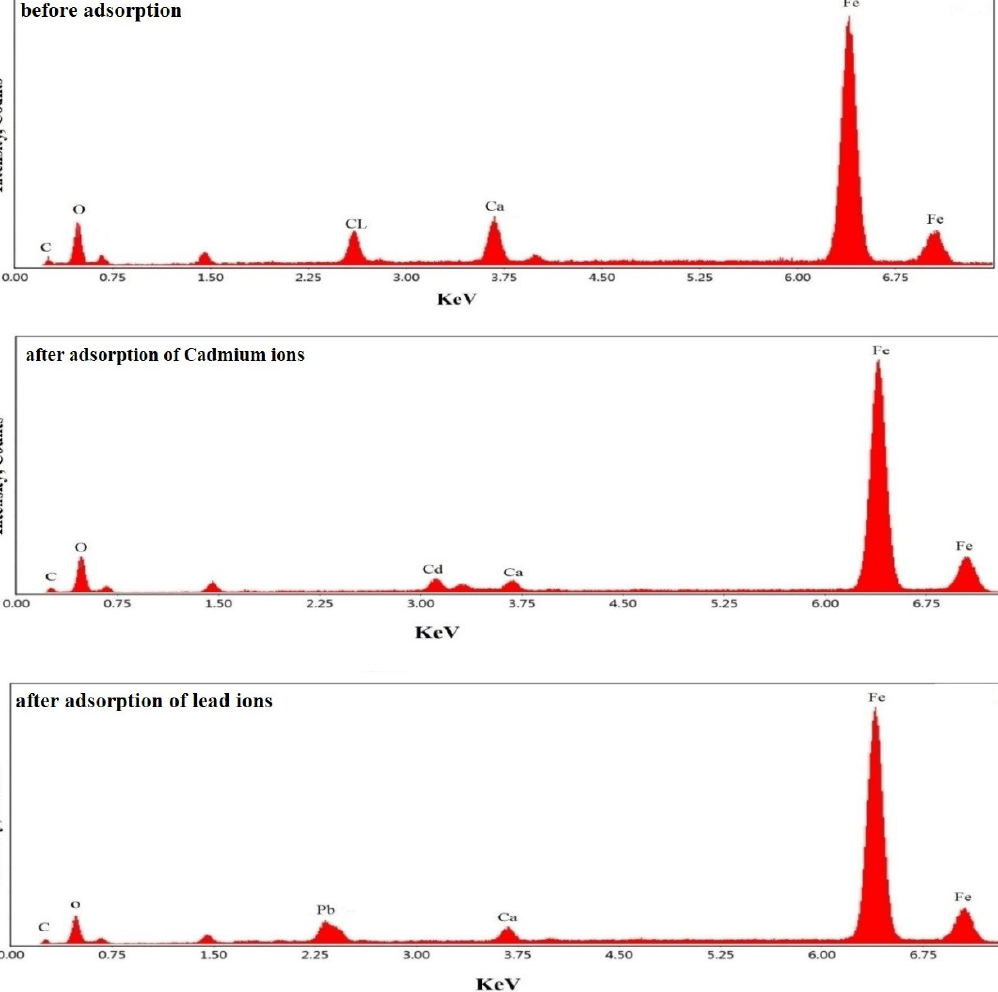
Fig. 3 b. The EDS spectra of adsorbent before adsorption, after adsorption of lead ions, and after adsorption of cadmium